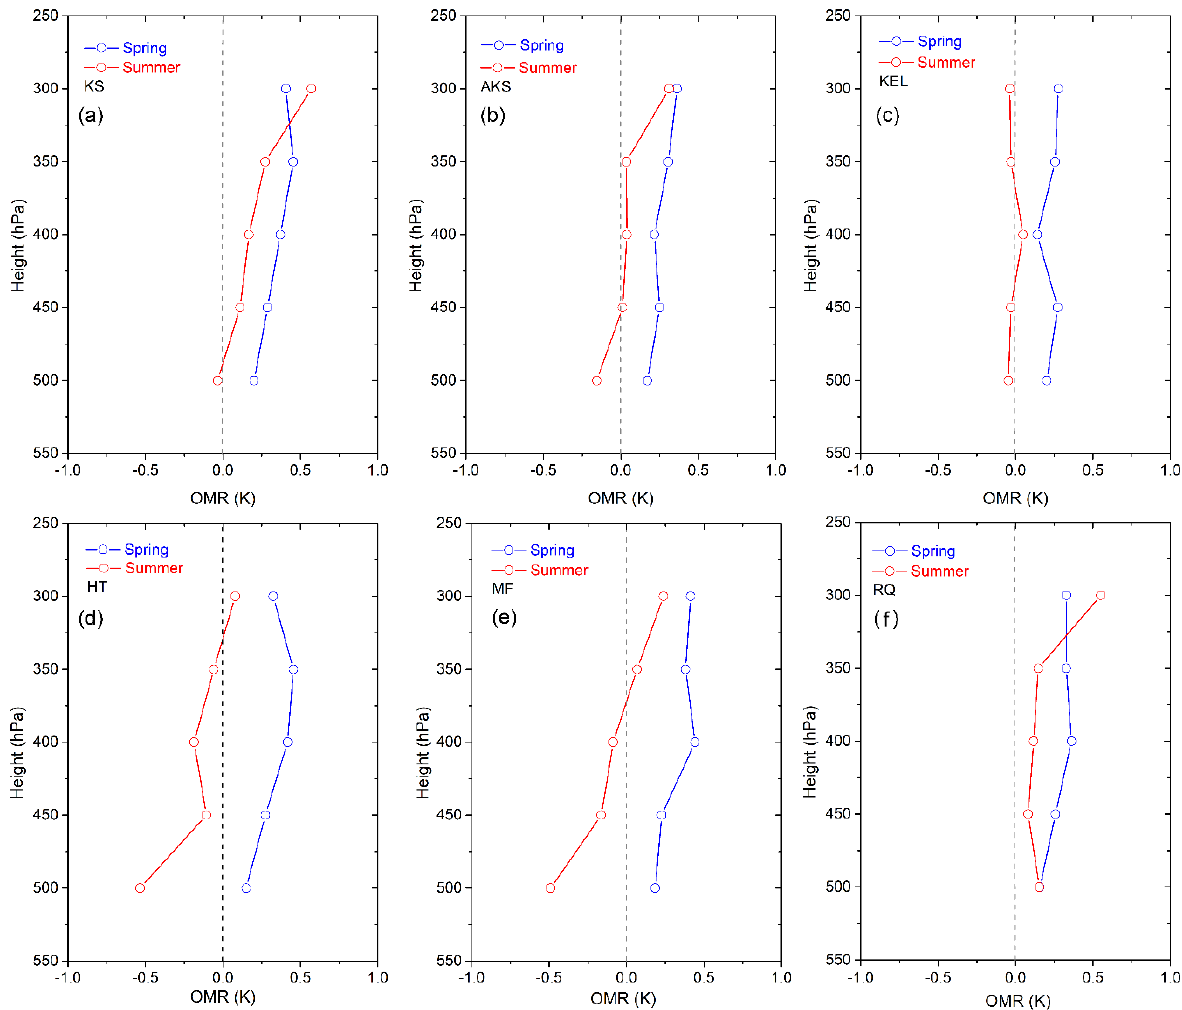
Figure 6. Profiles of the temperature difference (radiosonde observations minus ERA-5 data) in the spring and summer of 2016–2017 at the